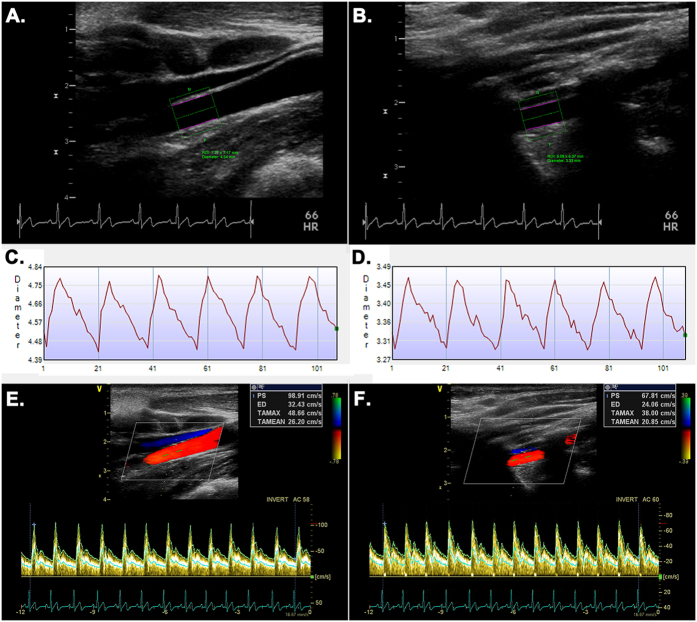
Measurement of cerebral blood flow at internal carotid (ICA) and vertebral arteries (VA) with color-coded duplex ultrasonography.The double purple lines within the region of interest (ROI, green rectangle) are the detected vessel inner walls in the high-resolution video clip of the ICA (A) or VA (B), which are used to track continuous pulsatile change of vessel diameter at the ICA (C) or VA (D) using an edge-detection and wall-tracking software (Brachial Analyzer, Medical Imaging Applications LLC, USA). Beat-by-beat recording of blood flow velocity at the site of vessel diameter measurement for the ICA (E) or VA (F) is presented. PSV, peak systolic velocity; ED, end-diastolic velocity; TAMAX, time-averaged max velocity; TAMEAN, time-averaged mean velocity.